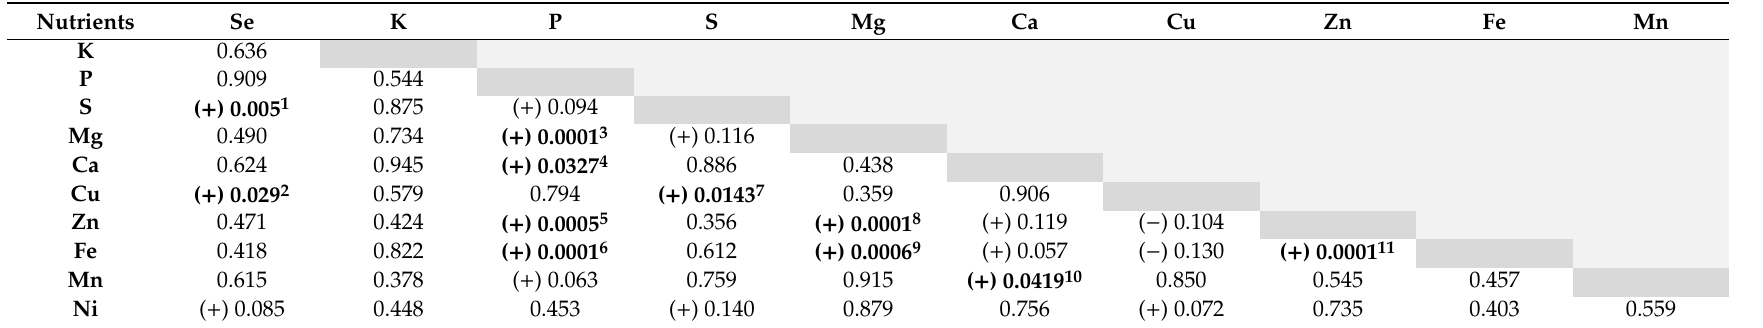
Table 6. p -values for positive ( + ) and negative ( − ) correlations between nutrient concentrations in Brazil nut batches A + B ( n = 26).